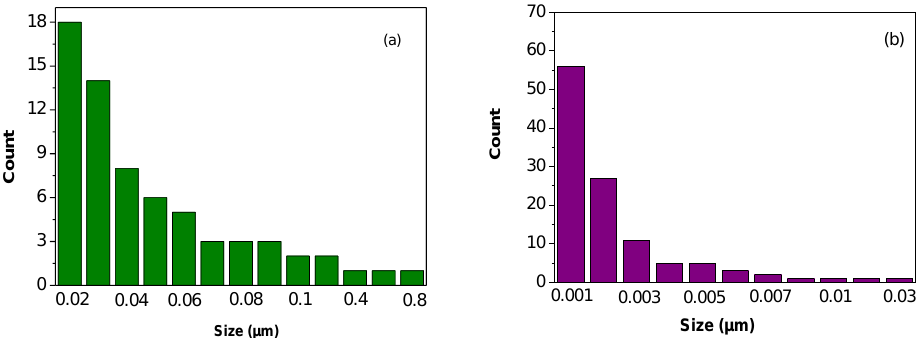
Figure A2. Size distribution of the PP droplets in the PE matrix: ( a ) PE/PP (without compatibilizer) and ( b ) PE/PP/EOC (83/10/7).